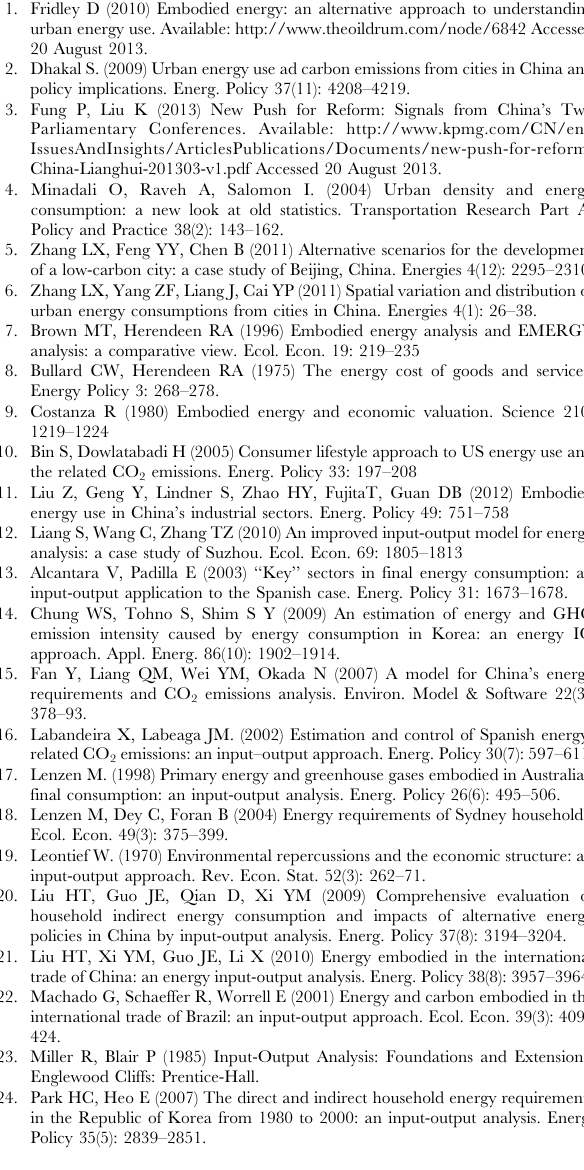
Table S1 Direct sectoral energy consumption associat- ed with the concerned 9 years (unit: Mtce). Table S2 Embodied energy consumption by sectors associated with the concerned 9 years (unit: